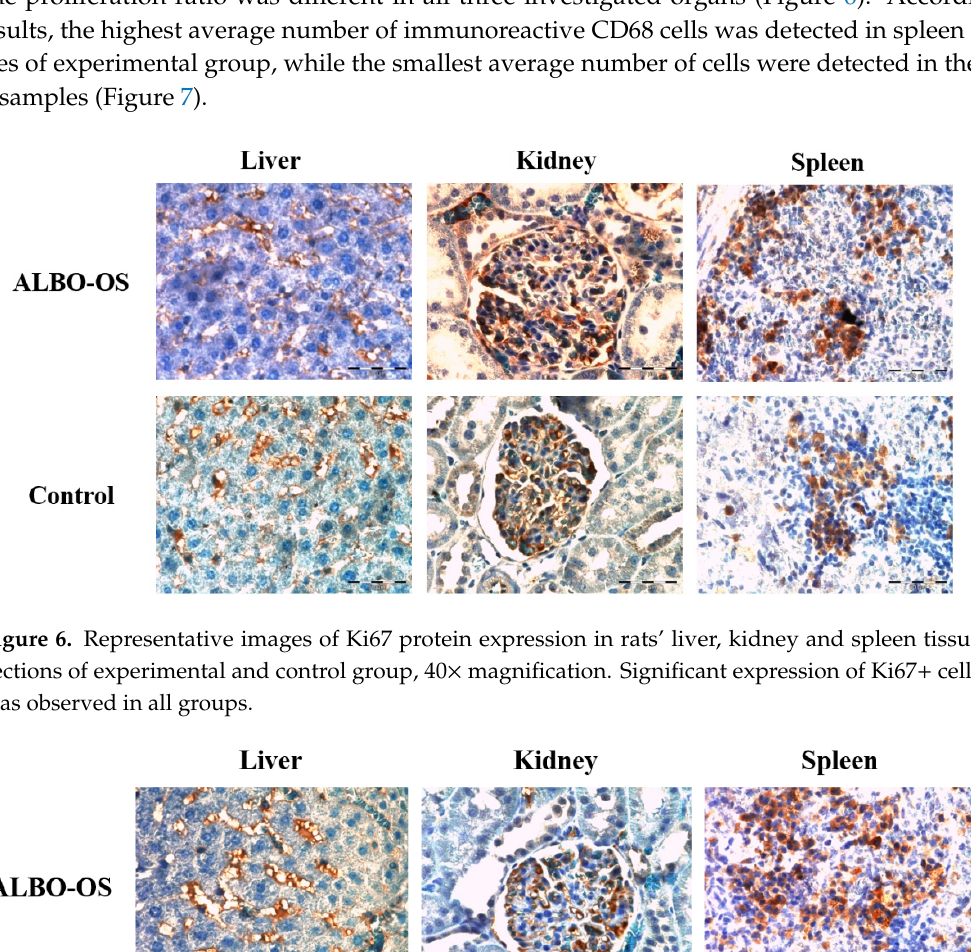
Figure 8. Percentage area of Ki67 ( A ) and immunoreactive CD68+ ( B ) stained cells was calculated with ImageJ using 3 images per organ. The results were analyzed with a two-way ANOVA, a p value < 0.05 was considered significant.